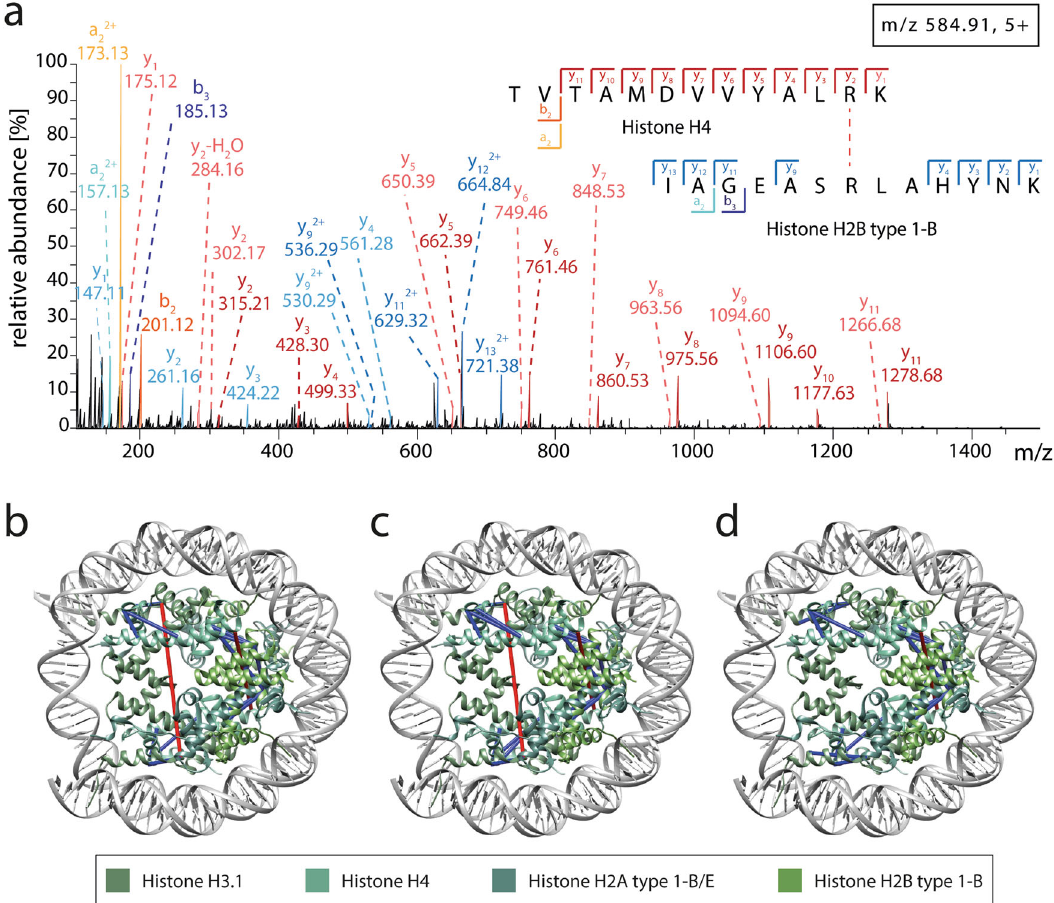
Fig. 5 Cross-links identi fi ed for histones. a Example fragment spectrum of an inter-protein cross-link between histone H4 and histone H2B. The m/z and charge state of the precursor ion are given. Y-ions (light red), y-ions including the mass shift of 12 Da (dark red), a-ions (orange) and b-ions (yellow) of the peptide originating from histone H4 as well as y-ions (light blue), y-ions including the mass shift of 12 Da (blue), b-ions (dark blue) and a-ions (cyan) of the peptide originating from histone H2B type 1-L are assigned. Note that not all observed fragment ions are annotated. b – d High-resolution structure of the nucleosome core particles containing two copies of histones H3, H4, H2A and H2B (PDB ID: 3x1s 56 ) are shown. Identi fi ed cross-links are visualised in the structure (red and blue lines). Cross-linking distances >30 Å (red) and <30 Å (blue) are indicated. b Cross-links identi fi ed in RA-differentiated cells. c Cross-links identi fi ed in RA/PMA-differentiated cells. d Cross-links identi fi ed in undifferentiated cells. Figure generated using Supplementary Data